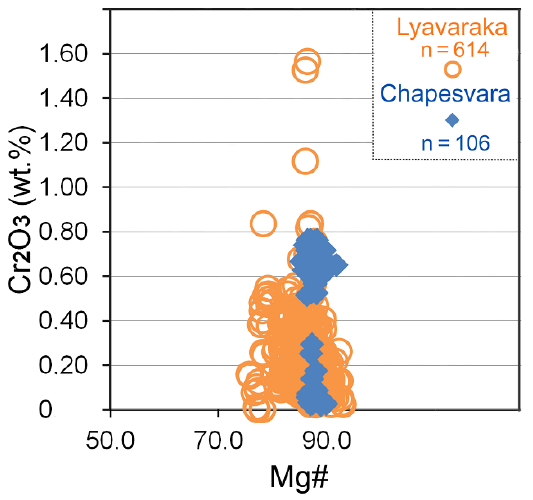
Figure 11. Plot of values of the Mg# index, i.e., 100 Mg/ (Mg + Fe 2+ + Mn), vs. contents of Cr 2 O 3 in WDS compositions of orthopyroxene from the Lyavaraka complex (orange symbol) compared with those from the Chapesvara complex, Serpentinite Belt (blue symbol), after [12].